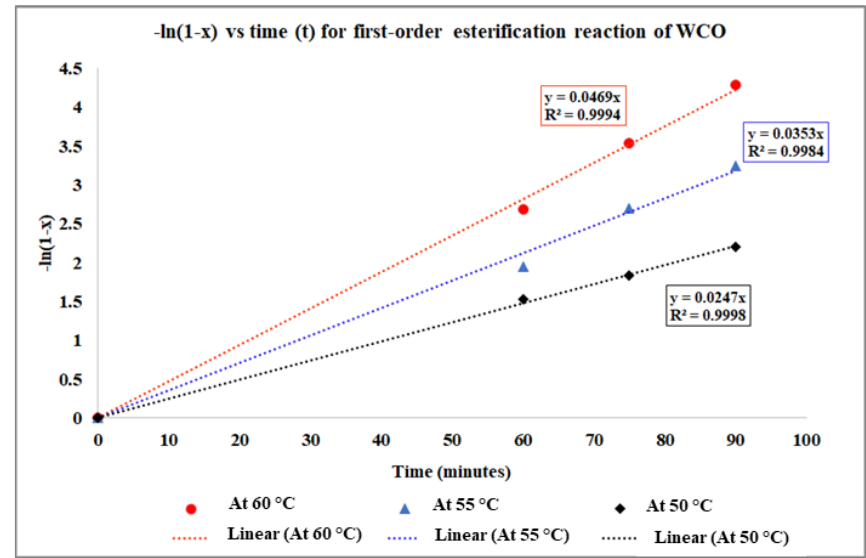
Figure 10. Determination of the reaction constants for the esterification reaction kinetics of WCO. Table 2 can be obtained by comparing the figure (Figure 10) with the − ln(1 − x ) = k 1 t equation. Table 2. 1/ T vs. ln k 1 relation for WCO esterification.